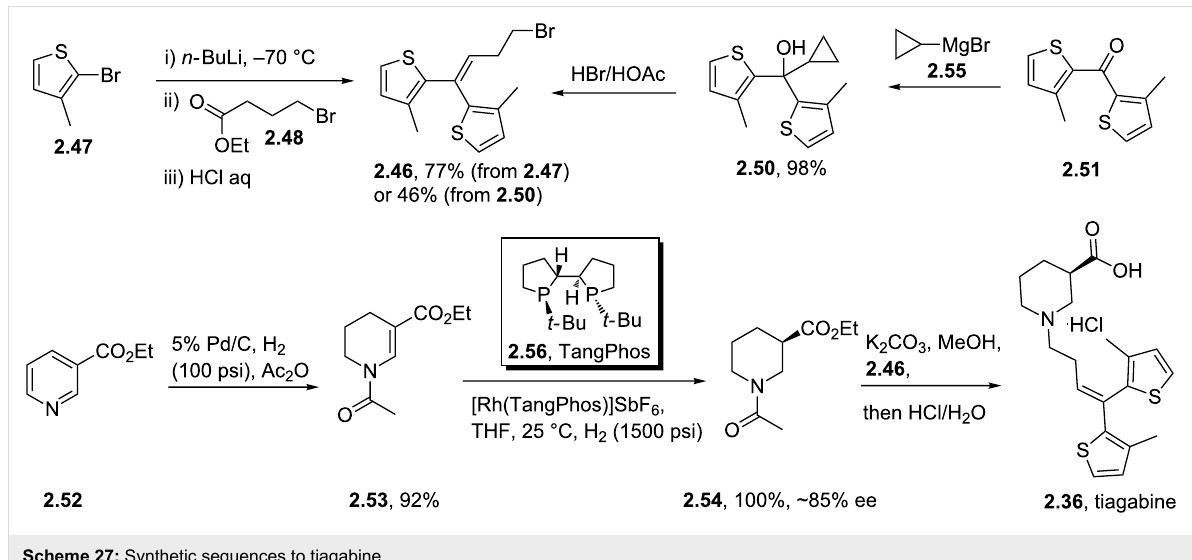
Scheme 27: Synthetic sequences to tiagabine.